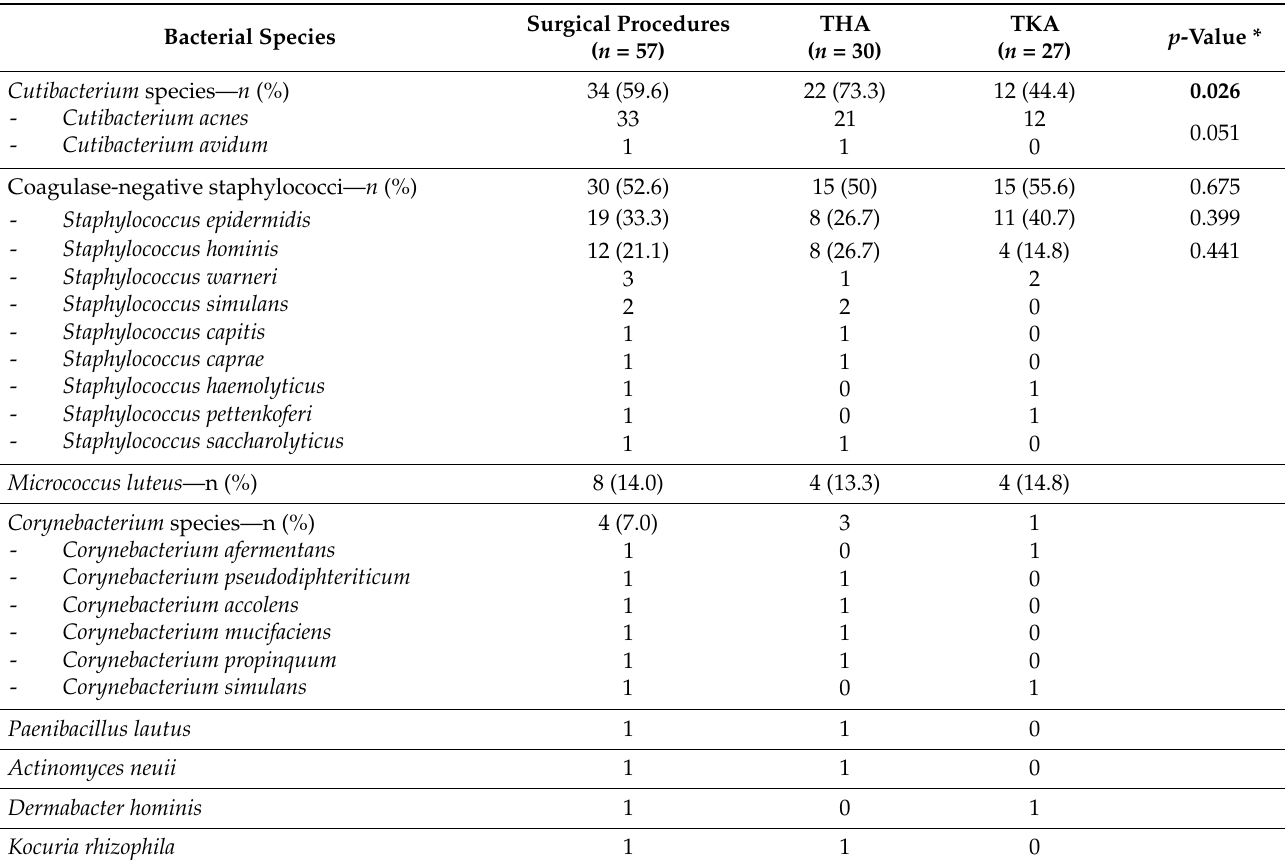
Table 2. Bacterial species isolated from intraoperative samples during total hip and knee replacement surgical procedures with positive